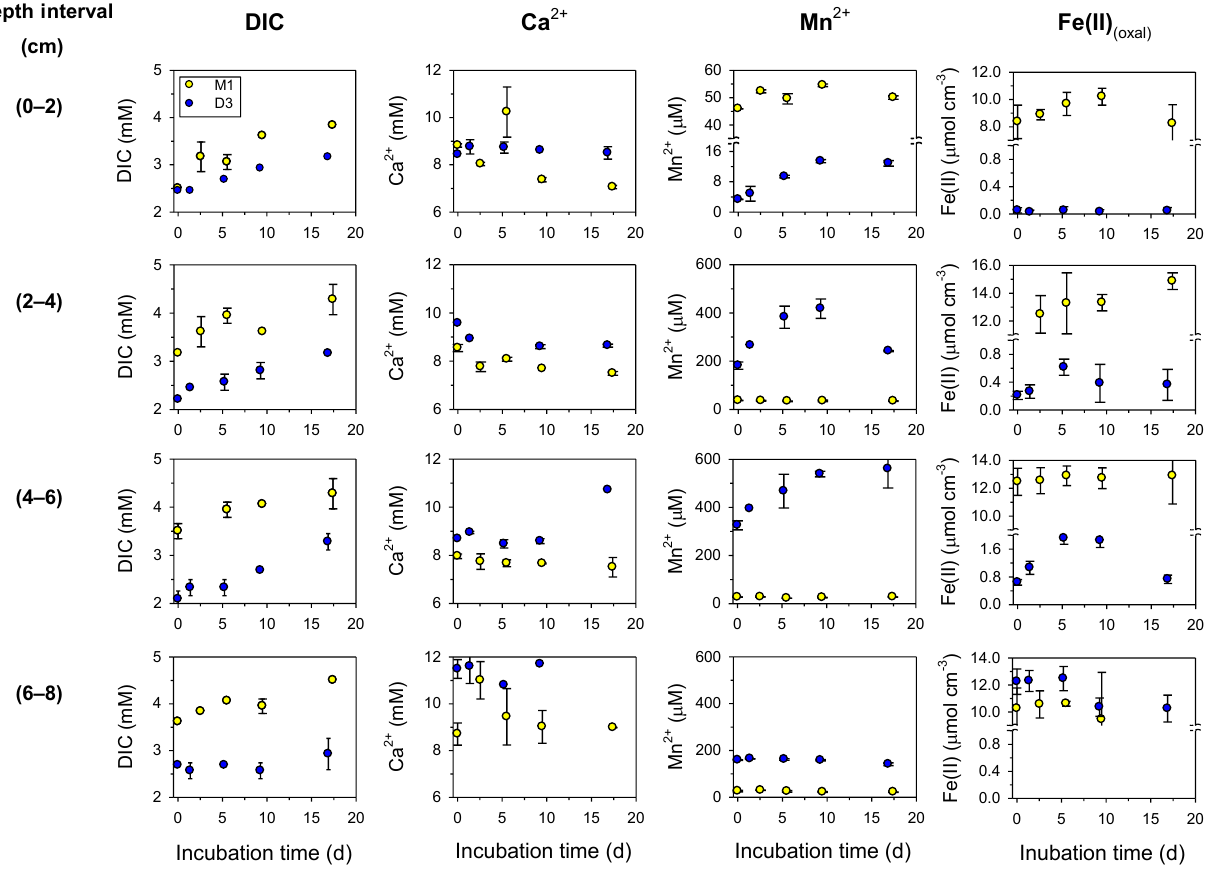
Figure 4. Changes of concentrations of DIC, Ca 2 + , and Mn 2 + in pore water and contents of solid-phase Fe(II) (oxal) during anoxic bag incubations of sediments from 0–2, 2–4, 4–6, and 6–8cm depth at M1 and D3. Data obtained at the 8–10cm depth interval are not